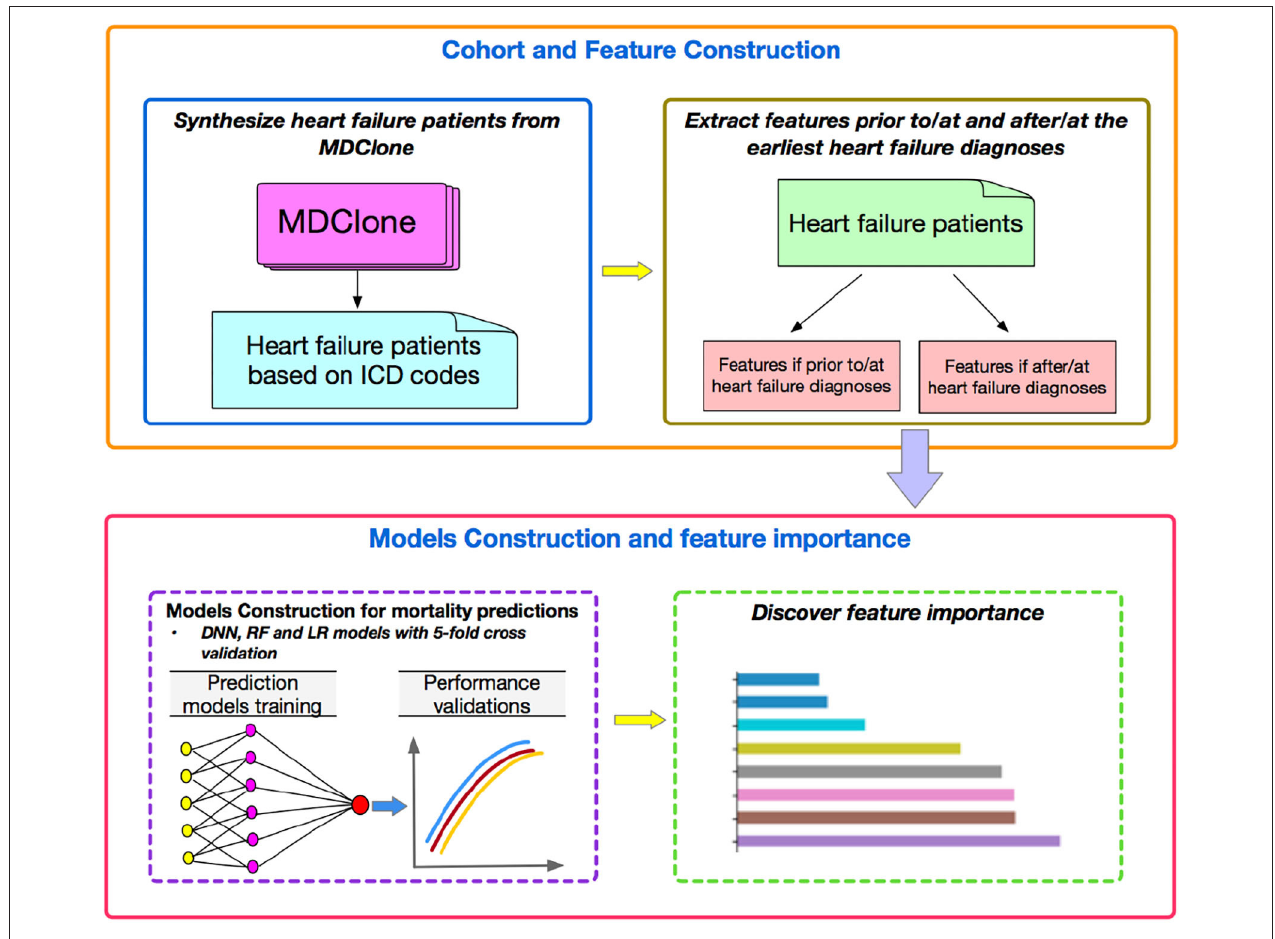
FIGURE 1 | The Flowchart of our